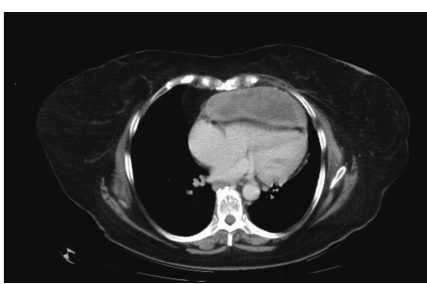
Figure 3: CT of chest showing 9.9 × 11.5 × 14.2 cm heterogeneous mass, with internal necrosis and calcification, associated with the anterior pericardium and displacing the heart superiorly and poste- riorly.